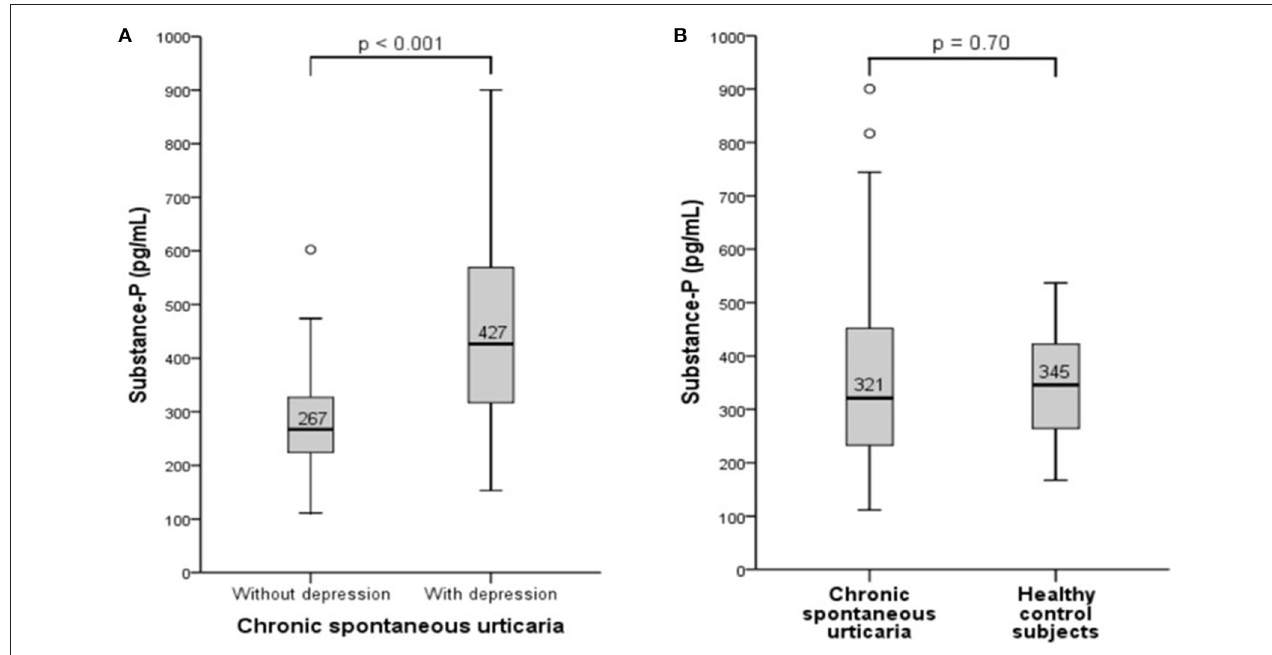
FIGURE 2 | Serum levels of Substance P are higher in CSU patients with depression than in those without. Substance P was measured by ELISA and serum concentration was compared between CSU patients with and without depression (A) and between CSU patients and healthy controls (B)